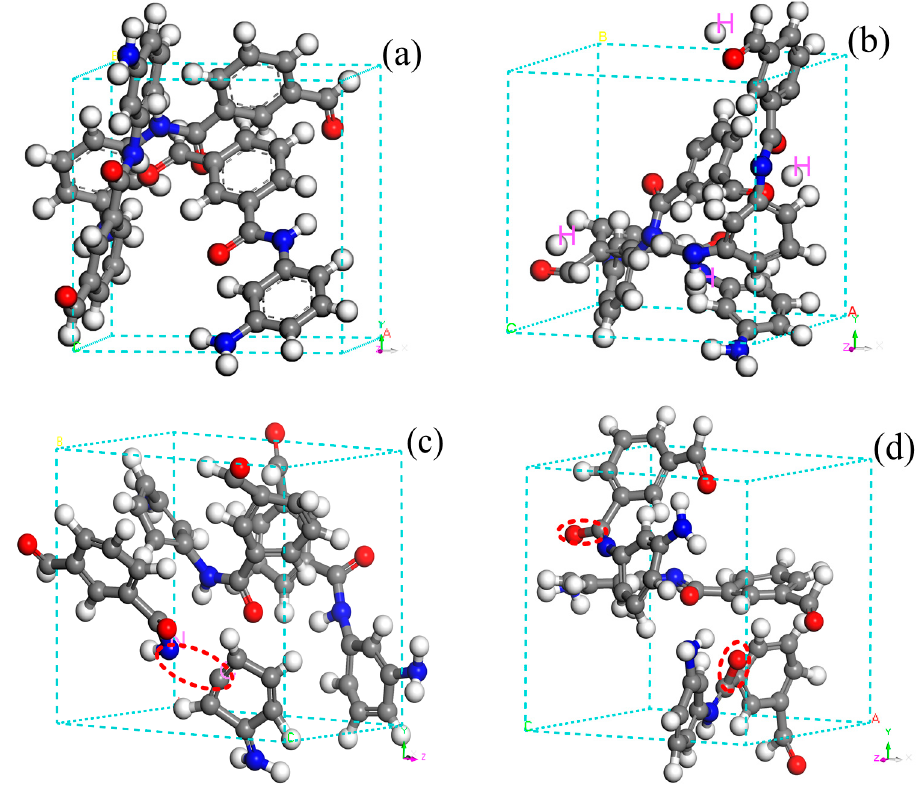
Figure 3. Chemical bond fracture behavior for the initial reaction: ( a ) initial model, ( b ) dehydrogenation reaction, ( c ) C aromatic ring –N bond fracture, and ( d ) C=O bond fracture.